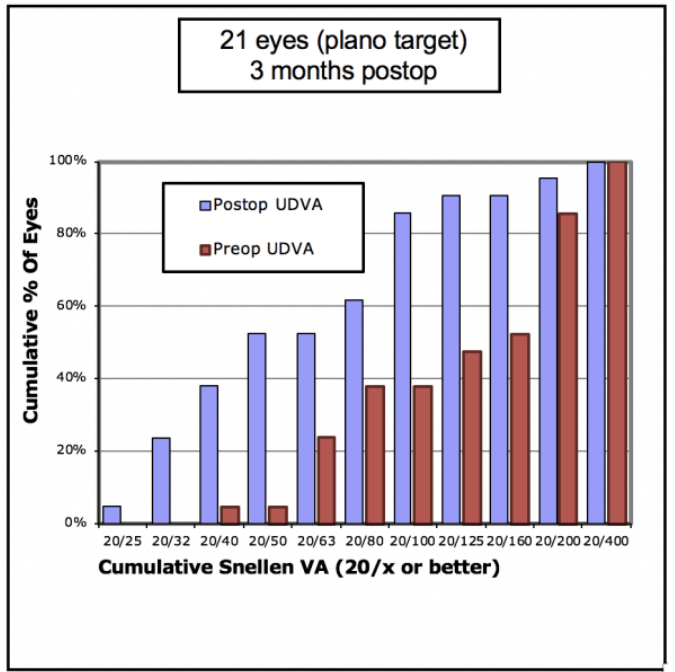
Figure 2. Cumulative pre-operative versus post-operative unaided distance visual acuity (UDVA) in 21 keratoconic eyes with Ferrara intrastromal corneal ring segments.